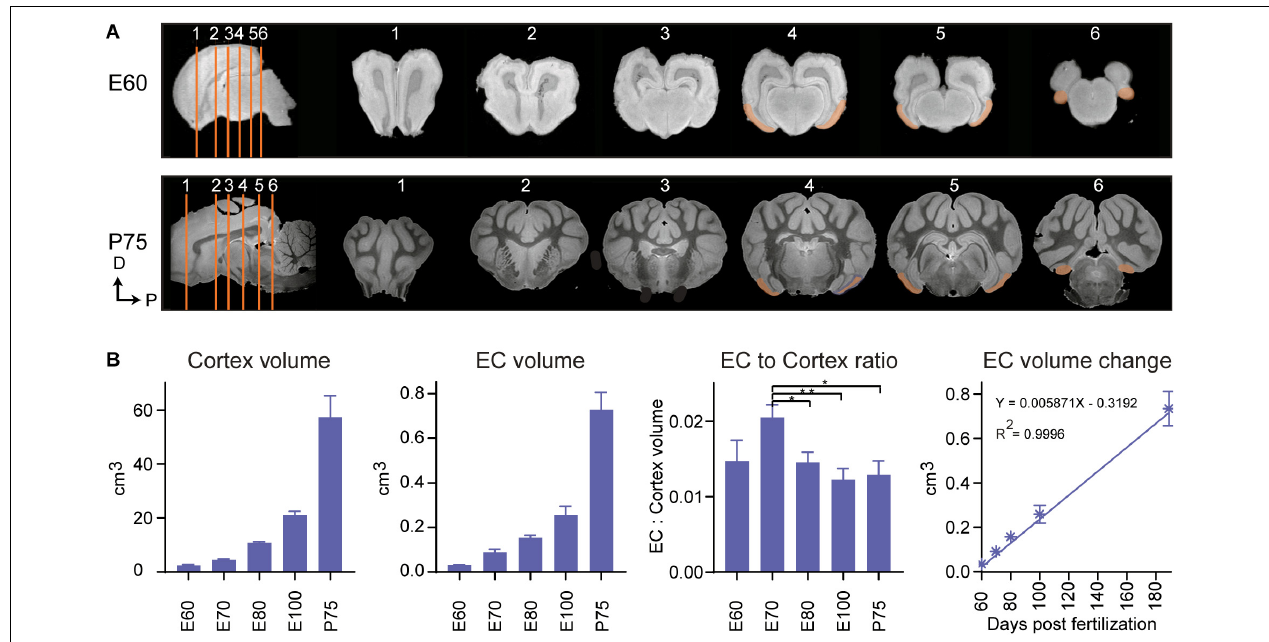
FIGURE 4 | Magnetic resonance imaging (MRI) of the developing entorhinal cortex (EC) shows extensive growth at the end of the 2nd trimester. (A) MRI shows the rostral to caudal position of the early developing EC at embryonic day (E)60 and postnatal day (P)75 in the coronal plane (sections depicted by orange lines). Dorsal (D) and Posterior (P). (B) The total cortex volume, the EC volume, the EC:Cortex ratio and the change in EC volume over time shows an overall linear growth pattern during development, but an exceptional growth spurt of the EC compared to the rest of the neocortex at E70 during development.